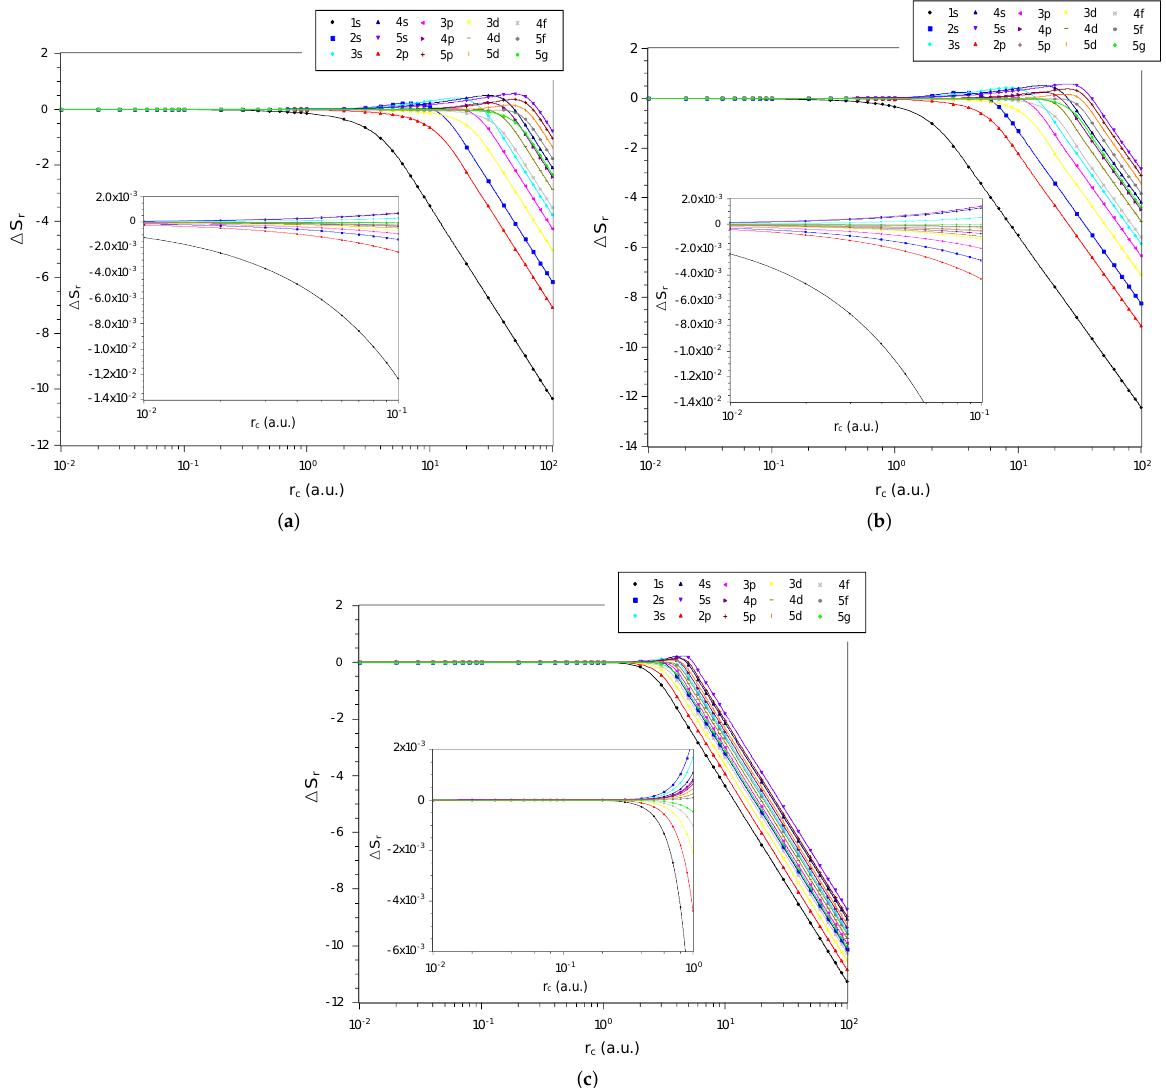
for rigorous confinements and the system starts to behave like an electron confined in a spherical cage.